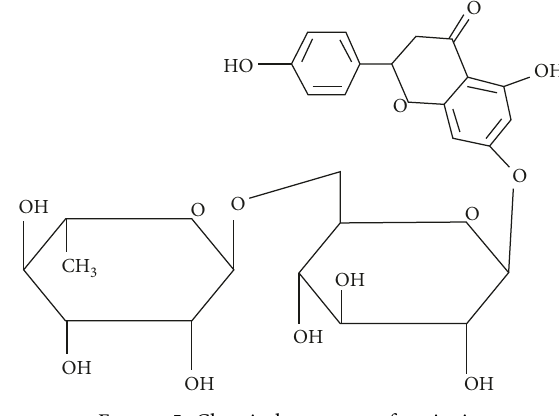
Figure 5: Chemical structure of naringin.